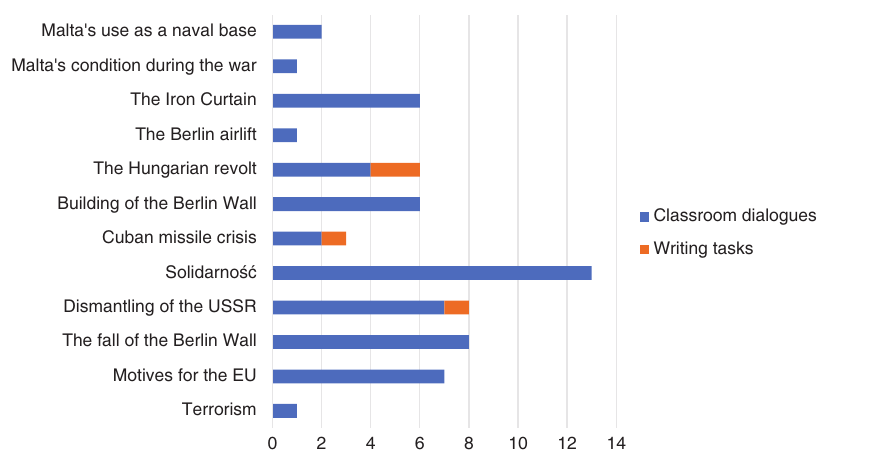
Figure 1: Frequency of students’ references to the wider historical picture for each